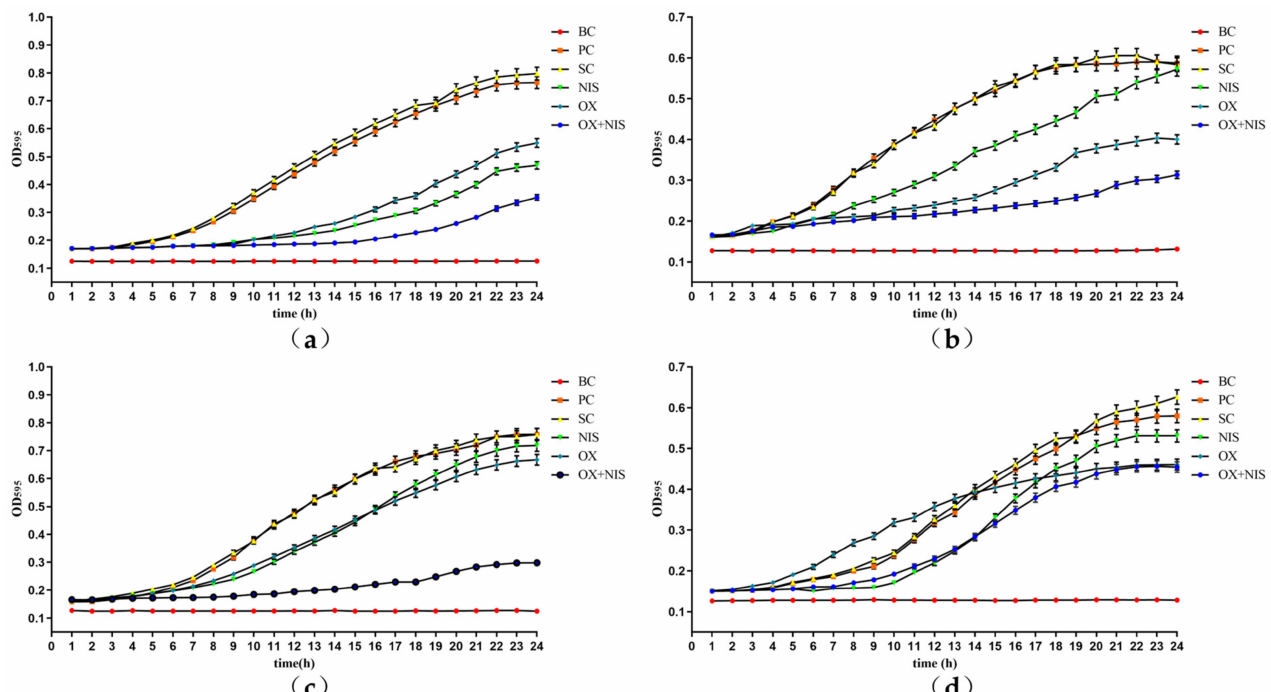
Figure 2. The growth curve of MRSA treated with OX, NIS and OX + NIS, with control of BC (Blank control), PC (positive control) and SC (solvent control). ( a ) Yn2020043; ( b ) Yn2020051; ( c ) Yn2020070; ( d )